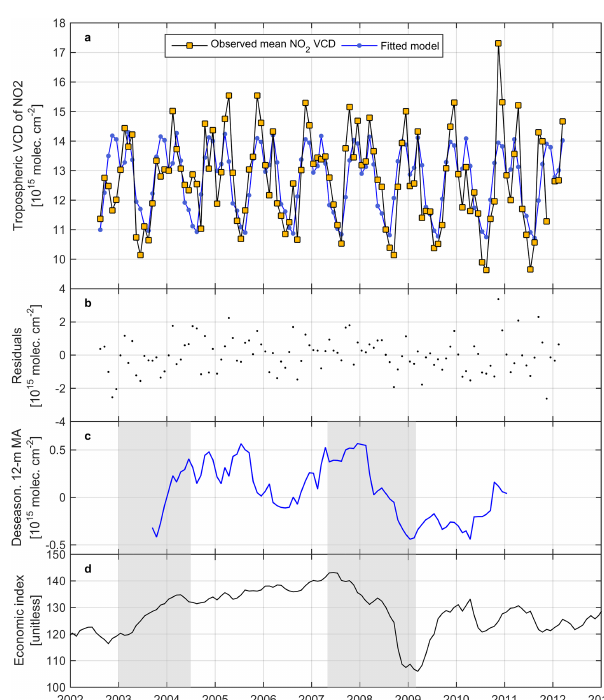
Figure 5. Average time series of SCIAMACHY-derived tropo- spheric NO 2 column computed over all study sites including a fitted trend model (a), the model residuals (b), the 12-month moving av- erage of the deseasonalized time series (c), and the ECRI Weekly Economic Index. Gray boxes in the two lowermost panels mark pe- riods where the overall NO 2 levels in the studied urban agglomera- tions appear to be indicative of overall economic